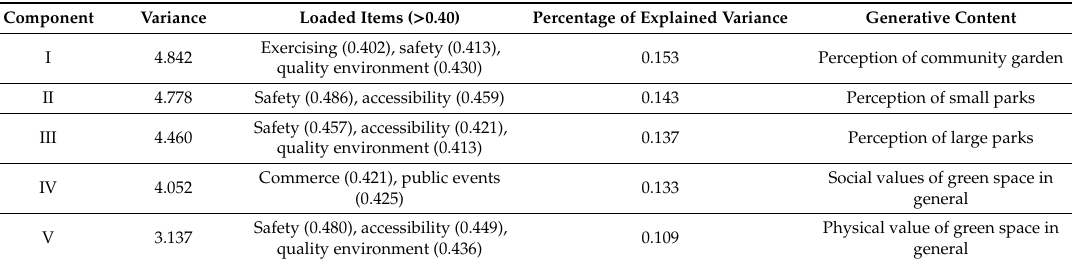
Table 3. Principal components of green space